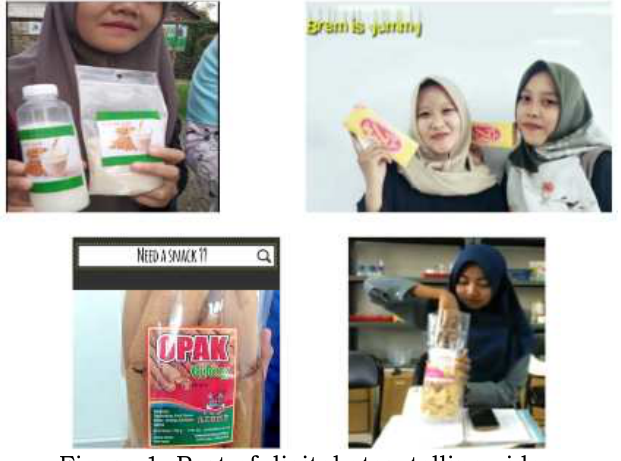
Figure 1. Part of digital storytelling